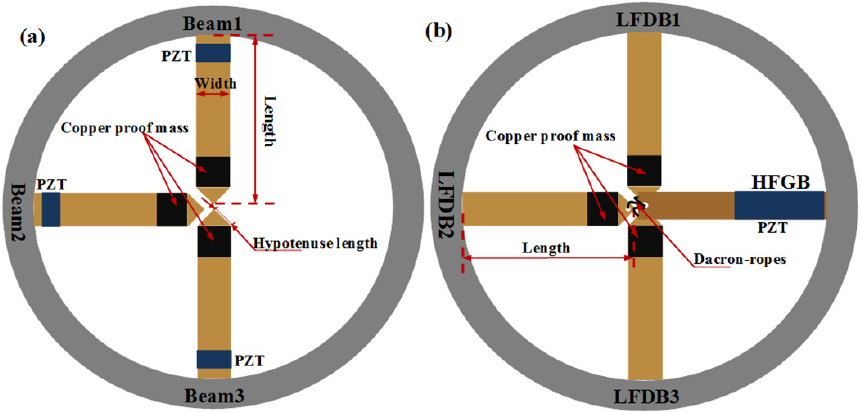
Figure 4. Experimental geometric construction of AB-VEH ( a ) and novel VEH ( b ) systems. Table 1. The parameters of AB ‐ VEH and novel VEH systems .